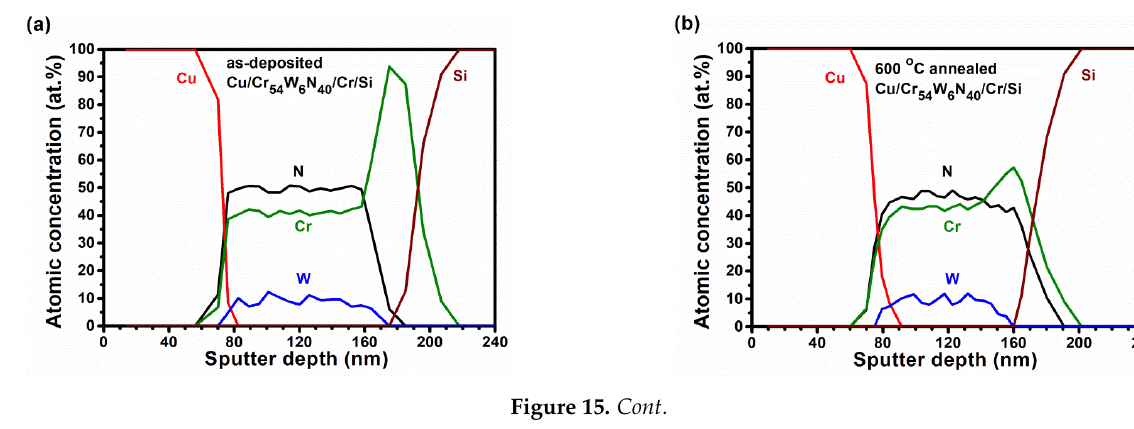
Figure 15. AES depth profiles of ( a ) as-deposited, ( b ) 600 °C, and ( c ) 650 °C annealed Cu/Cr 54 W 6 N 40 /Cr/Si samples. (Annealed in vacuum for 1 h)